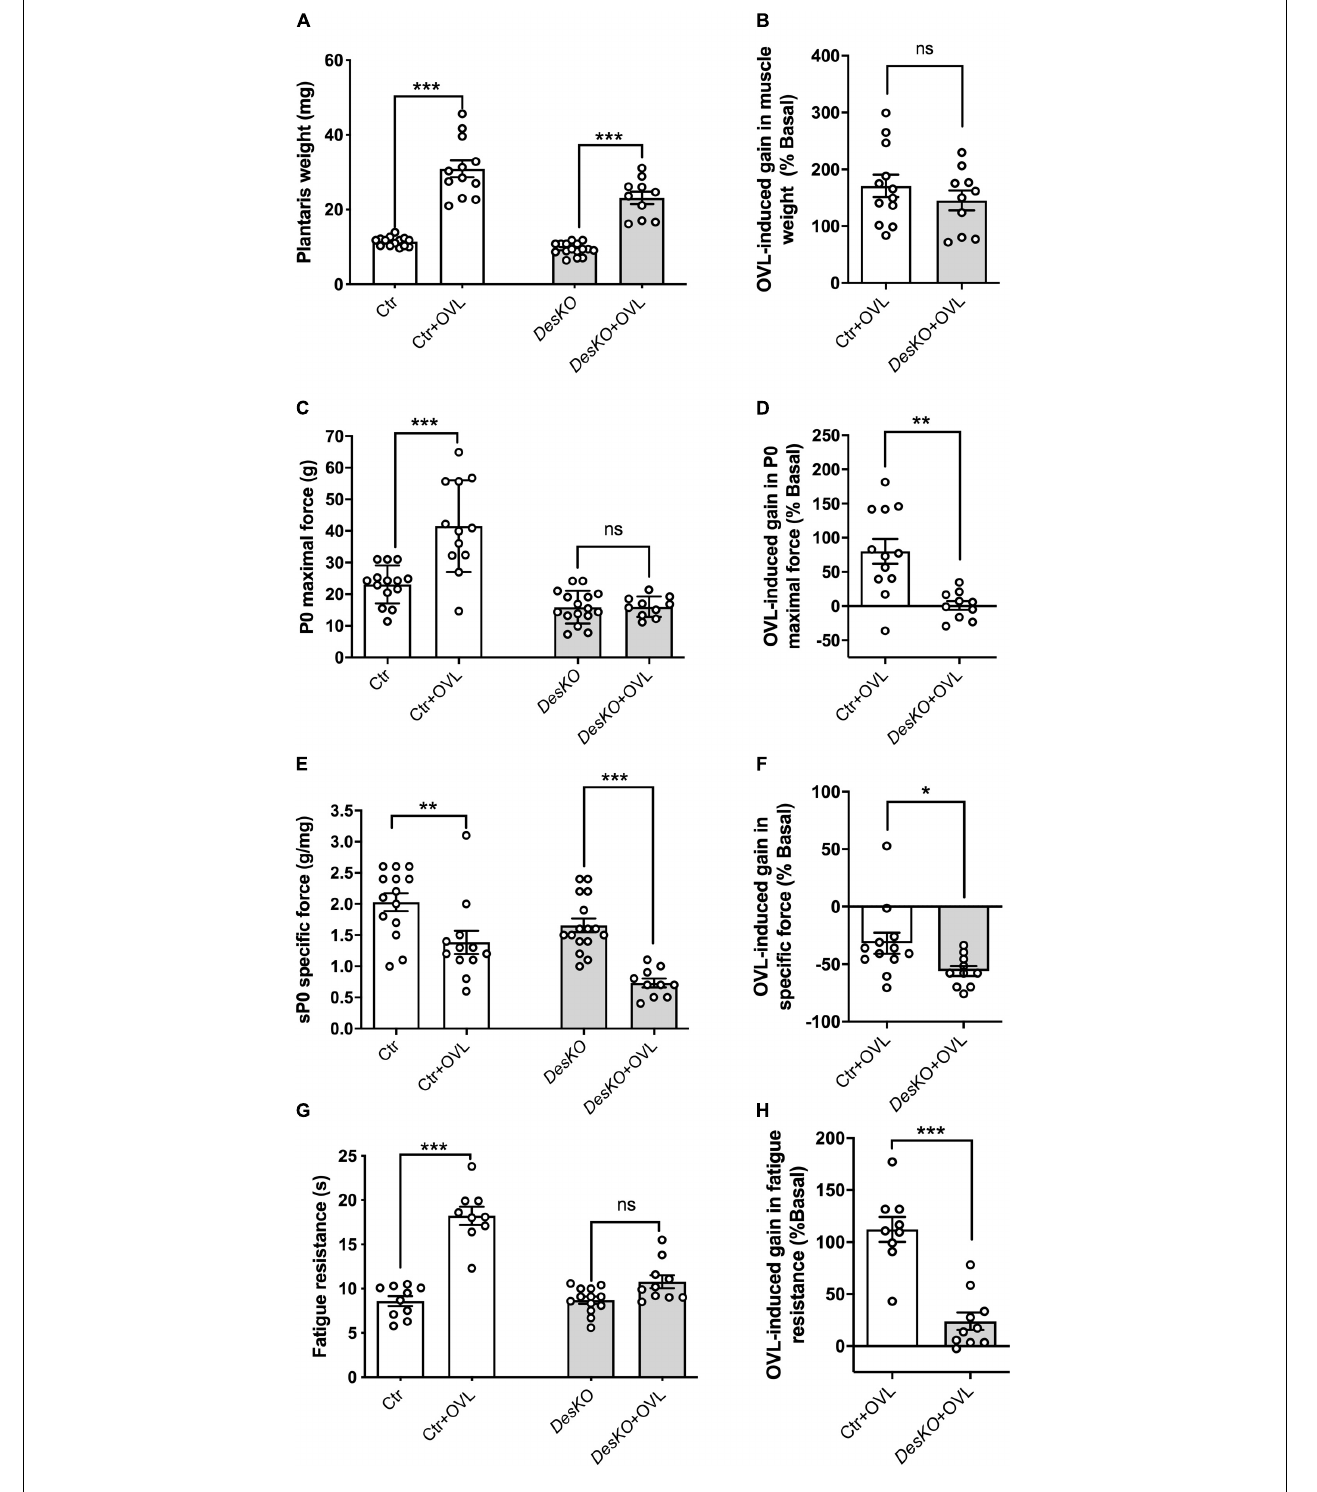
FIGURE 1 | Maximal force of plantaris is not increased in response to OVL in DesKO mice. Muscle weight (A) , maximal force (P0, C ), specific force (sP0, E ) and fatigue resistance (G) were evaluated in both genotypes (Ctr and Des KO) in basal condition or after 1 month of OVL. The gain or loss in these parameters was calculated compared to the corresponding basal condition for the Ctr + OVL and Des KO + OVL groups (B,D,F,H) . Data are given as means ± SEM. Des KO, Desmin knock-out mice; Ctr, Control mice; OVL, mechanical overloading. ns : non-significant, * p < 0.05, ** p < 0.01, *** p < 0.001.